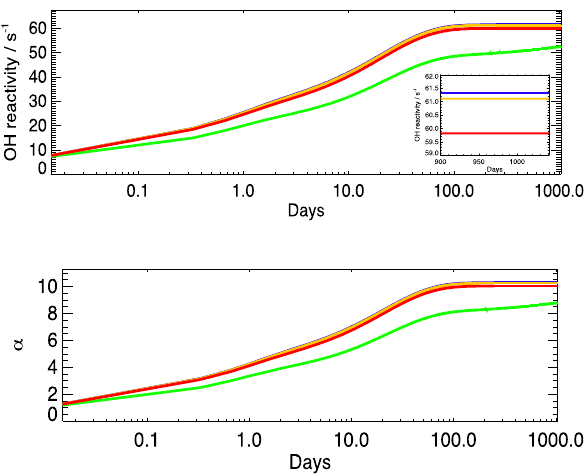
Figure 8: Evolution of total OH reactivity and α in the base simulation (dark blue, hidden beneath red and yellow)) compared with a simulation using photolysis rates calculated for a Fig. 8. Evolution of total OH reactivity and α in the base simula- tion (dark blue, hidden beneath red and yellow) compared with a simulation using photolysis rates calculated for a solar zenith an- gle of 45 ◦ (green), resulting in a value of j (O 1 D) of approximately 2 . 5 × 10 5 s − 1 . The effect of other oxidants on the calculated OH re- activity and α are shown using simulations that include O 3 mixing ratios of 10ppbv (yellow) and 100ppbv (red). The inset plot shows the spread of the calculated reactivities with different O 3 mixing ratios at steady state.